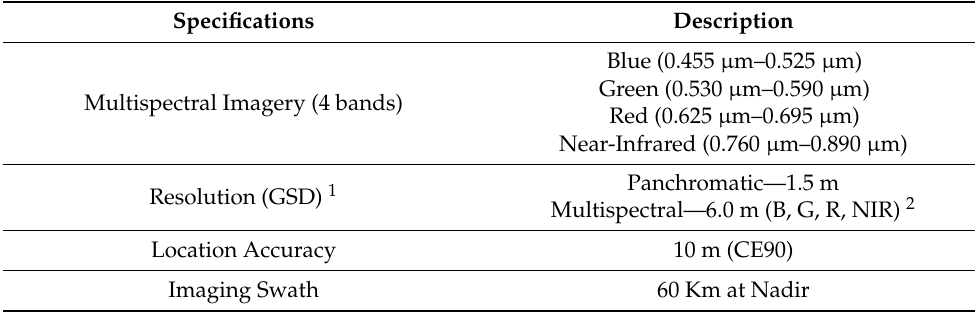
Table 1. SPOT 6 satellite sensor specifications